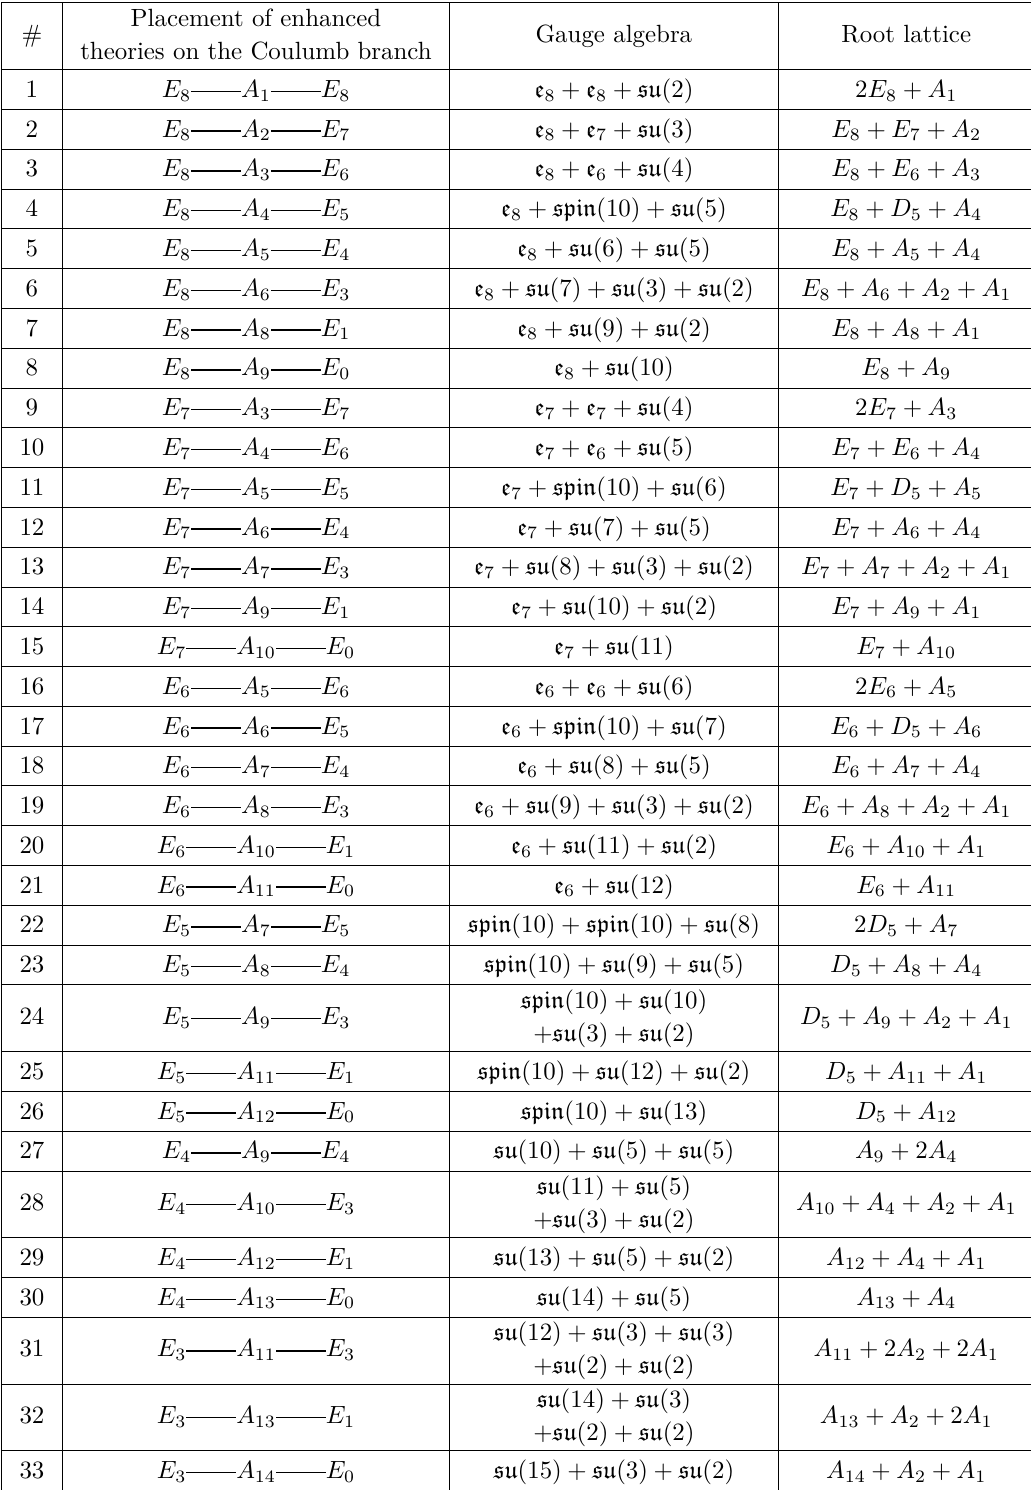
Table 2 . (Part 1 of 2) List of possible maximally enhanced rank 17 theories in nine dimensions which is obtained by Swampland considerations. The first 44 lines where the algebra is semisimple match with table 3 in [49] which have string theory